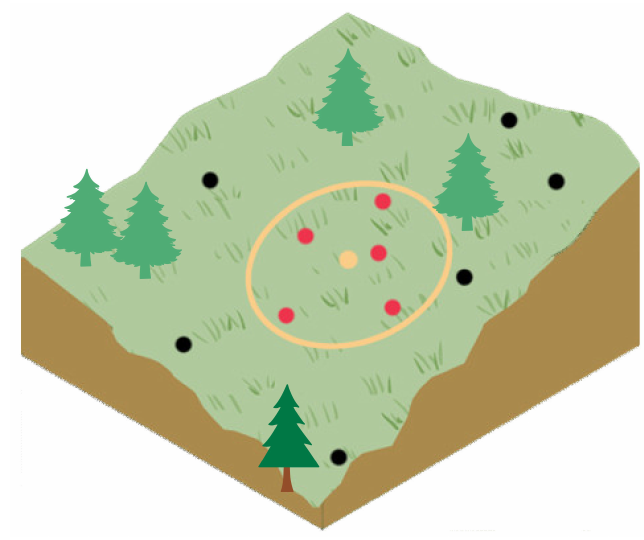
Figure 4. Diagram of the IDW search field.